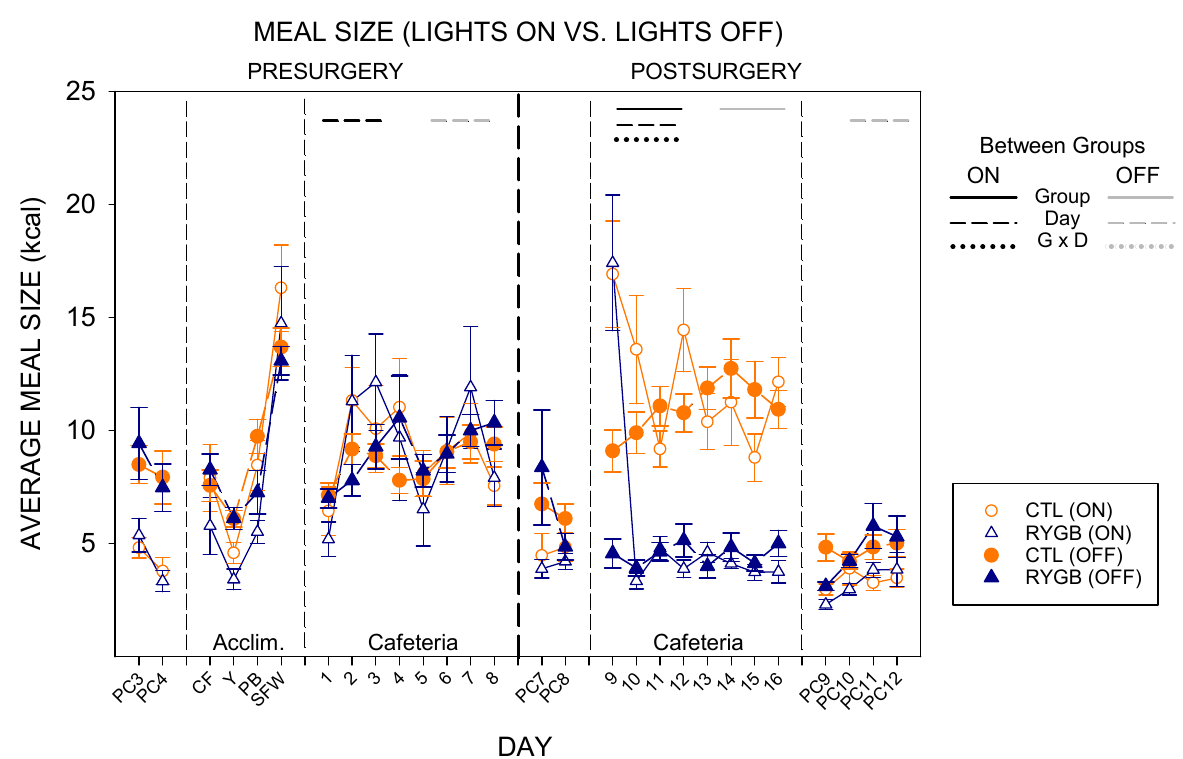
Figure 13. Meal Size for Meals with Lights On vs. Lights Off. Average (±SE) meal sizes when lights were on (open symbols) or off (filled symbols) for each day for CTL (combined SHAM and IRON groups, n = 14; orange circles) and RYGB ( n = 11; blue triangles) rats for powdered chow days (PC), acclimation days for each food (Acclim.; CF: chickpea flour; Y: yogurt; PB: peanut butter; SFW: sugar/fat whip), and cafeteria diet days. Dashed vertical lines indicate transitions between diet conditions (thin dashed) and between pre- and post-surgical phases (thick dashed). Statistically significant results from between-group two-way mixed ANOVAs (Table 14) are indicated by the legend; within-group ANOVA results are found in Table 15. Table 14. Two-way ANOVAs Comparing Meal Sizes for Lights-On and Lights-Off Meals between Groups for Each Diet Condition. LIGHTS-ON DAY G × D GROUP G ×